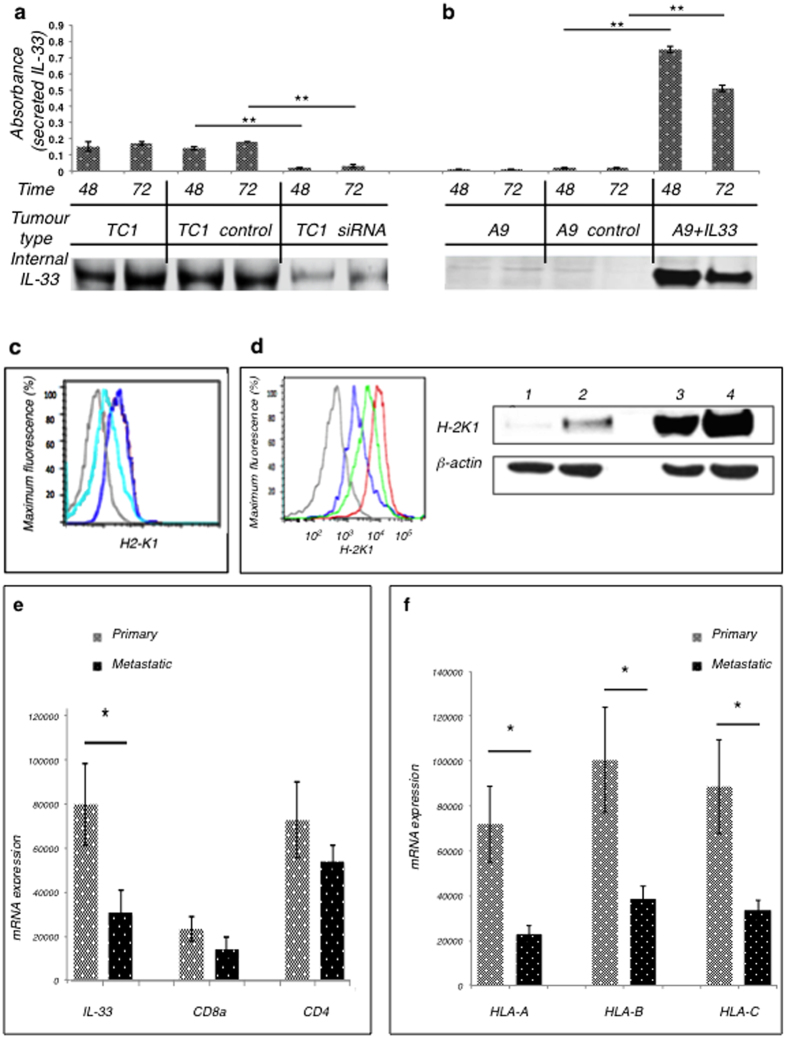
MHC-I expression is tied to the level of IL-33.(a,b) (top) Level of secreted IL-33 in supernatants measured by ELISA. (bottom) Level of IL-33 protein in the cell pellet measure by Western Blot analysis. (a) Down-regulation of IL-33 decreases secreted and intracellular IL-33 protein levels. Primary TC1 cells were treated with either scrambled siRNA or siRNA targeted against IL-33 for 48h or 72h. **P < 0.005 (Student’s t-test), comparing IL-33 secretion of TC1 cells transfected with siRNAs untargeted or targeted against IL-33. (b) Over-expression of IL-33 increases secreted and intracellular IL-33 protein levels. Metastatic A9 cells were transiently transfected with IL-33 gene or vector alone, and protein expression was tested after 48h and 72h. **P < 0.005 (Student’s t-test), comparing IL-33 secretion by A9 tumour cells transfected with IL-33 gene or vector alone. (c) Down-regulation of IL-33 gene corresponds with a decrease in MHC-I protein expression. Surface expression of MHC-I on TC1 cells was measured using flow cytometry, after cells were treated for 72h with siRNA: anti-IL-33 siRNA (aqua), untargeted siRNA (blue), no stain control (grey). (d) Over-expression of IL-33 gene increases MHC-I protein in tumour cells. Expression of MHC-I on A9 tumour cells was measured 48 h after transfection with IL-33. (d, left) Flow cytometry: An increase in IL-33 expression resulted in increased MHC-I surface expression on A9 cells: A9 untransfected control (grey); A9+vector alone (blue); A9+IL-33 (green); A9 treated with IFN-gamma, positive control (red). (d, right) WesternBlot: Increase in IL-33 gene expression restores A9 MHC-I protein expression. Lane 1 = A9 cells, Lane 2 = A9+vector; Lane 3 = A9+IL-33; Lane 4 = A9+IFN-gamma cytokine (50ng/ml). ß-actin was used as loading control. (e,f) HLA expression is co-regulated with IL-33 levels in human prostate cancer. Expression levels of mRNA of IL-33, CD8a, CD4 (e) and HLA-A, HLA-B, HLA-C (f) in castration-resistant prostate cancer (CRPC) are low relative to benign prostate tissue and both low- and high-risk primary tumours. D’Amico Risk classification: low-risk = prostate-specific antigen (PSA) ≤ 10, Gleason score ≤ 6, and clinical stage T1-2a; high-risk = PSA > 20, Gleason score ≥ 8, or clinical stage T2c-3a. *P < 0.05 (Student’s t-test) when compared high-risk primary (treated) tumours and metastatic CRPC.